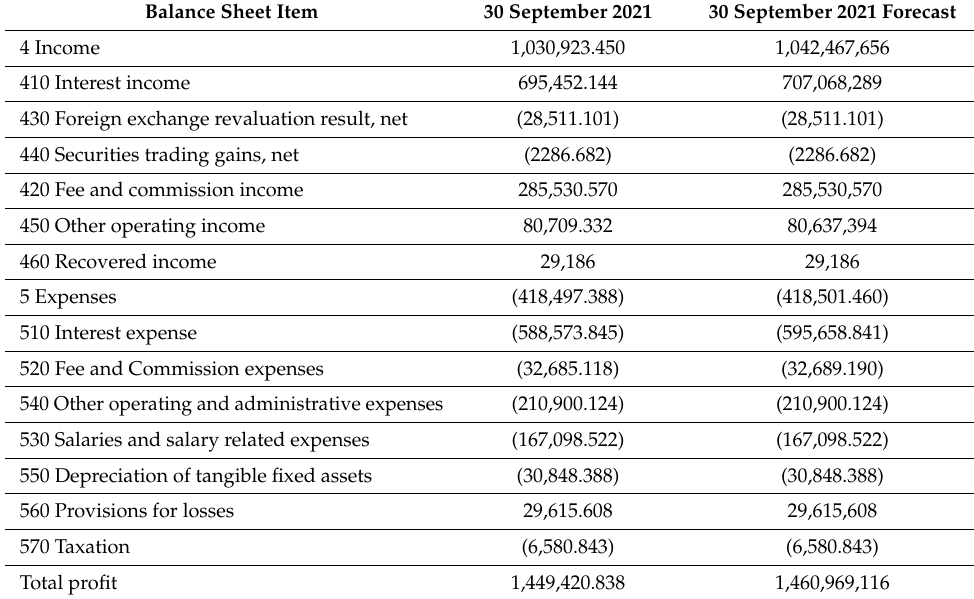
Table 5. Income and expense statement with initial data and forecast data. Balance Sheet